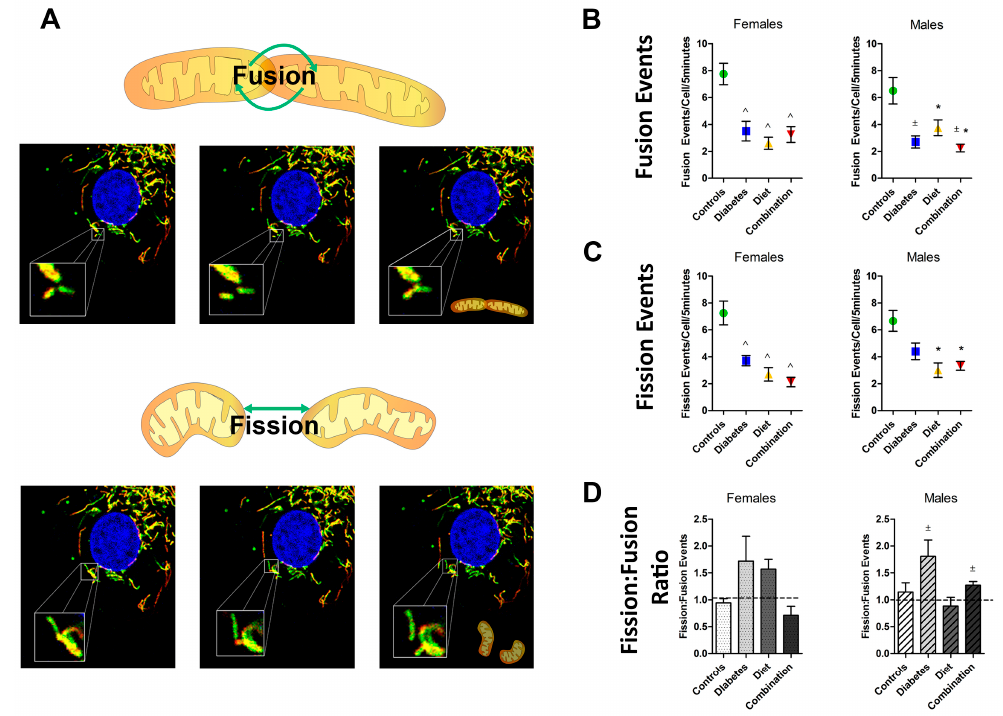
Figure 2. Maternal diabetes and a high-fat diet impaired mitochondrial dynamism in newborn rat cardiomyocytes (NRCM). Confocal live-cell imaging was used to count fusion and fission events of mitochondria in primary NRCM from controls and those prenatally exposed to maternal diabetes, a high-fat diet, or a combination of both. ( A ) Representative time lapsed images show mitochondrial fusion (joining of two separate mitochondria into one) in the top panels and fission (division of one mitochondrion into two) in the bottom panels. The average number of ( B ) fusion and ( C ) fission events/cell were counted in a 5 min recording. ( D ) A fission:fusion ratio was calculated to demonstrate imbalance and predict mitochondrial morphology. Group comparisons are shown for females ( n = 4–7/group) and males ( n = 4–6/group), respectively. Significant differences ( p ≤ 0.05) are indicated for ± diabetes and * diet by two-way ANOVA and ^ for interaction effect remaining by one-way ANOVA with comparison to controls by Dunnett’s post hoc analysis.